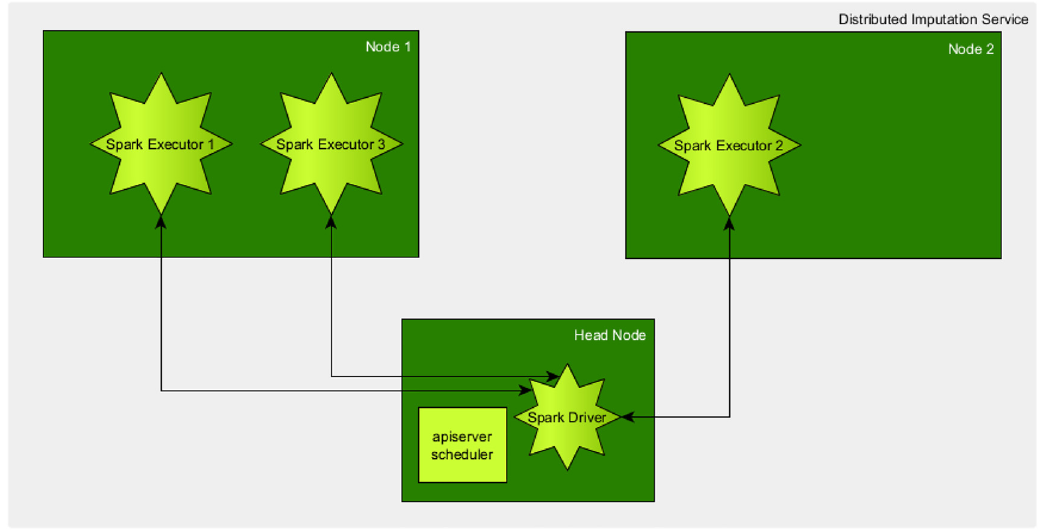
Figure 3: Depiction of the Architecture of Spark running in kubernetes. Head node creates a Pod for the Spark driver and schedules Spark executors on the computational nodes which are placed based on some load balancing. Example shown for only two computational nodes, in the real infrastructure multiple computational nodes would be added to the kubernetes cluster. Roughly inspired by